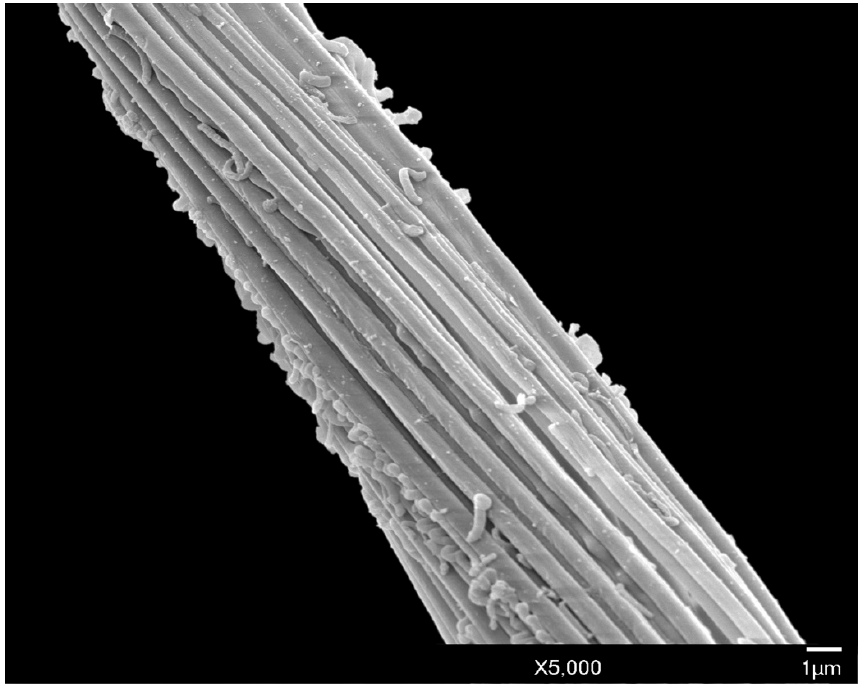
Figure 8. SEM close-up of male A. galliformis showing the setae of the glandular pouch composed of wax filaments.